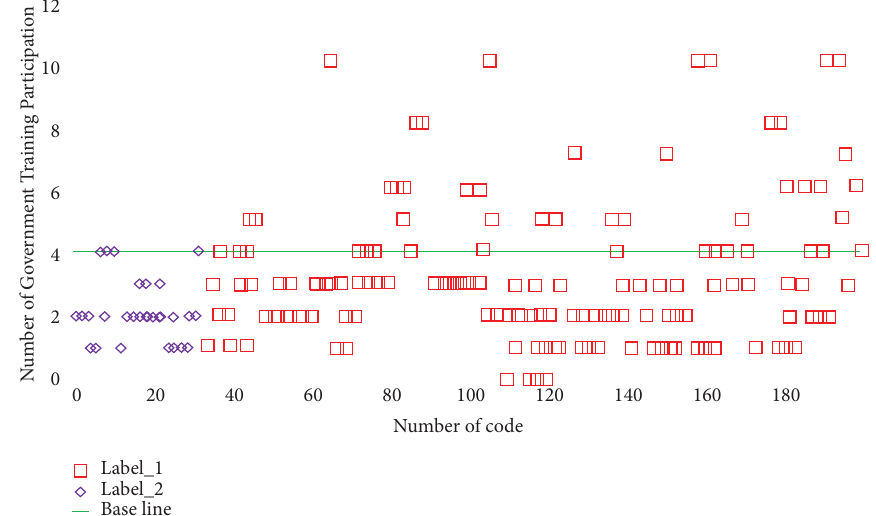
Figure 7: Predicted number of government training participation of low- and medium-level teachers by region.